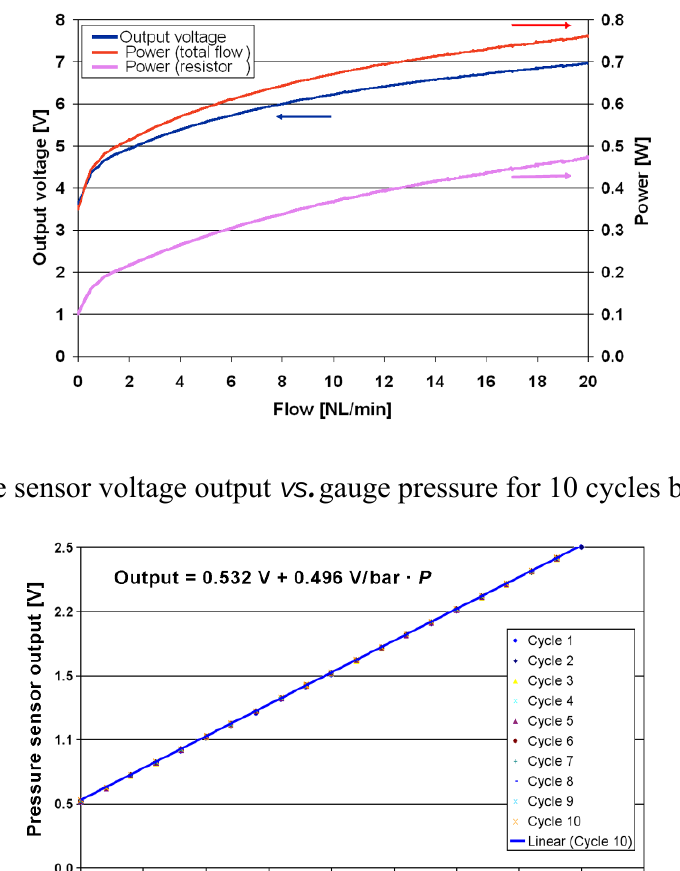
Figure 13. Flow sensor voltage output response and power consumption vs. flow for circuit #23-3.1 under 10 V.